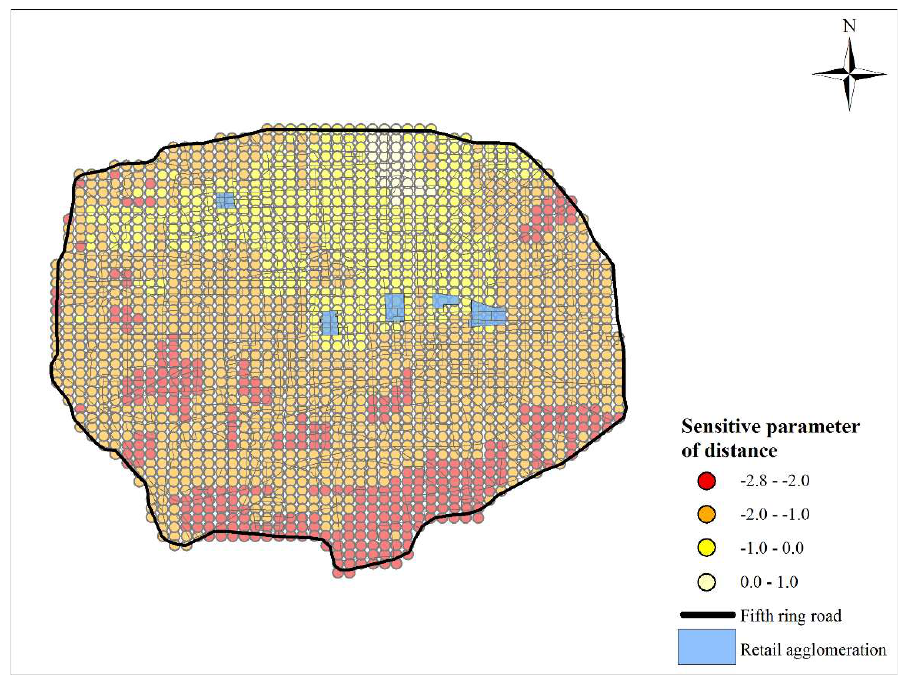
Figure 5. Spatial distribution of local sensitive parameters of distance